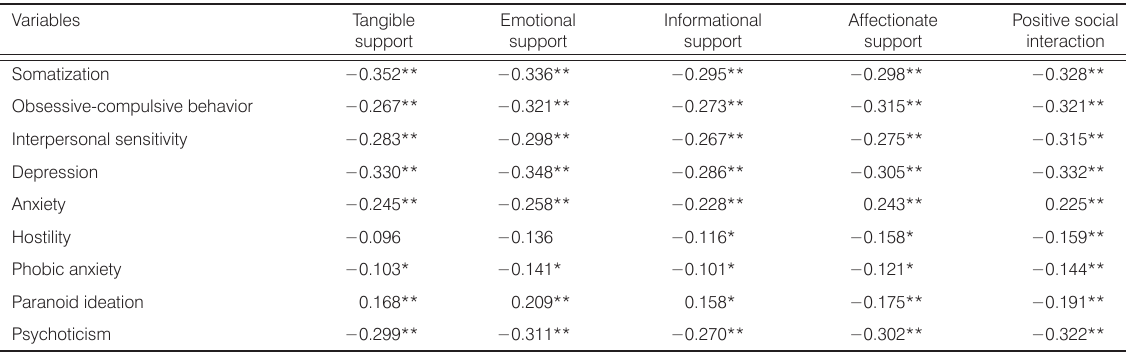
Table 4. Correlation coefficients of SCL-90 domains and social support subscales.